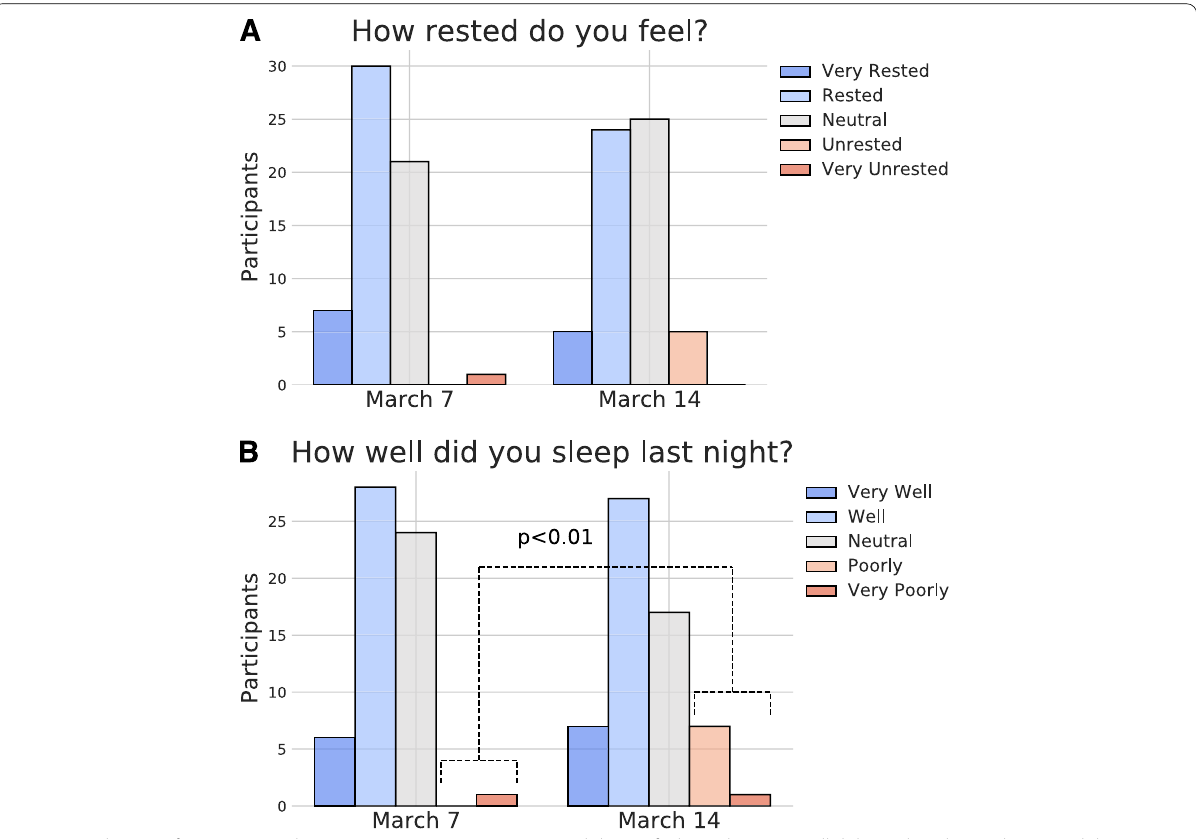
Fig. 5 Distribution of responses to the morning questions A “How rested do you feel?”, and B “How well did you sleep last night?” posed the mornings after Saturday March 7 (pre-DST transition) and after Saturday March 14 (post-DST transition). The bars show the number of participants whose response fell into each category. For the question “How well did you sleep last night?”, there was a significant increase ( p < 0.01) in the proportion of participants who responded “poorly” or “very poorly” on the night of DST transition in comparison to the previous Saturday